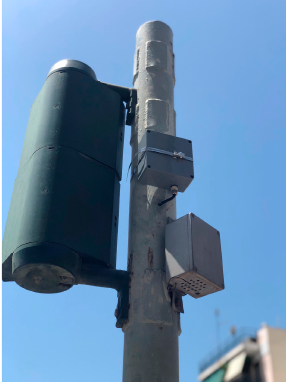
Figure 8. Specially mounted external device on a real traffic light located at the junction of Doiranis and Athinas in Kallithea.